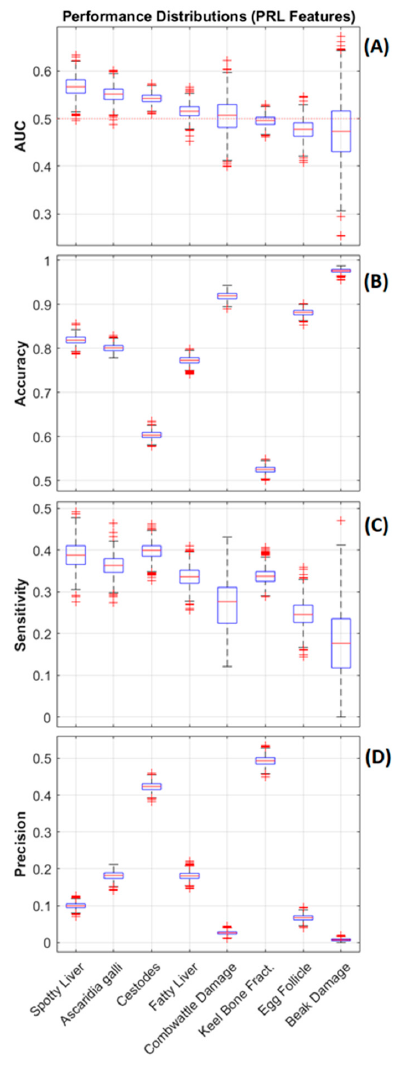
Figure 7. Performance distributions plotted as boxplots for each model using only the PRL features. Part ( A ) plots the area under the ROC curve (AUC), with the red dotted line marking the performance of a random-chance classifier. Part ( B ) plots the accuracy for each model. Part ( C ) plots the sensitivity, and part ( D ) plots the precision for the minority class within each response. The responses are ordered from left to right by descending mean